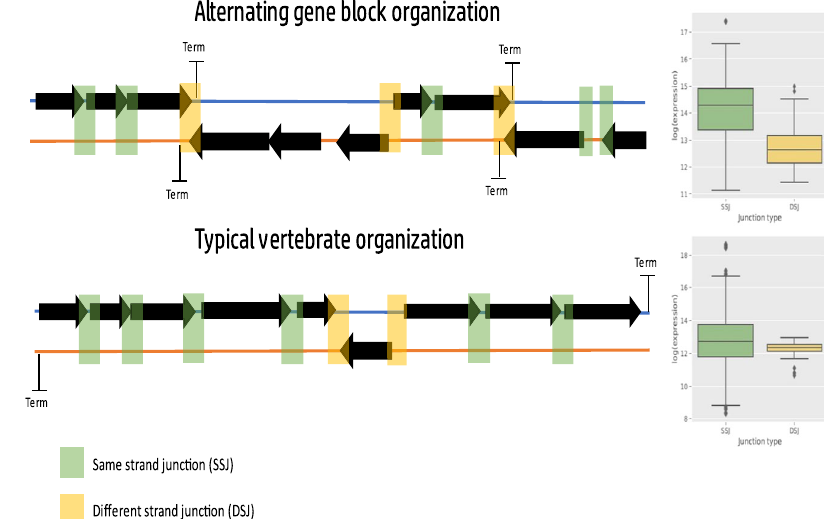
Fig. 7 Species with alternating gene block organization show a pattern of lower expression around DSJ. Illustration showing that transcription termination sites coincide with different strand junctions (DSJ) in organisms with alternating gene block organization. DSJ is in yellow, same strand junctions (SSJ) are in green. The semi-transparent rectangles mark the junction location, colored according to type. The boxplots on the right side present an example of the typical expression difference found in organisms with (upper panel) or without (lower panel) alternating gene block mtDNA